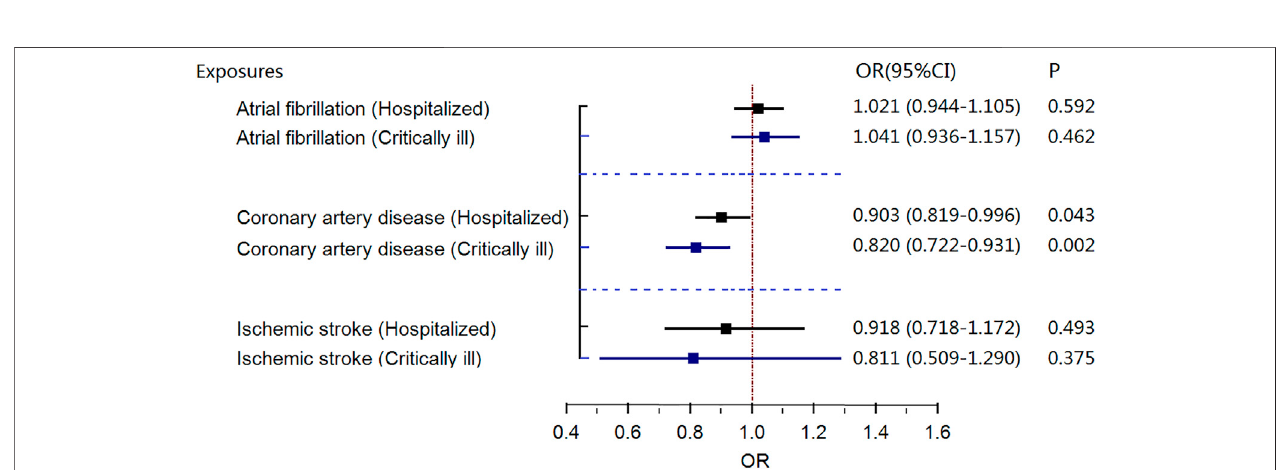
FIGURE 4 | Results of the random-effects MR IVW model investigating the causal association between gene-predicted three cardiovascular diseases and risk of severe coronavirus disease 2019 (COVID-19) in COVID-19 GWAS data (without UKBB data). CI, con fi dence interval; OR, odds ratio; MR, Mendelian randomization; COVID-19, severe coronavirus disease